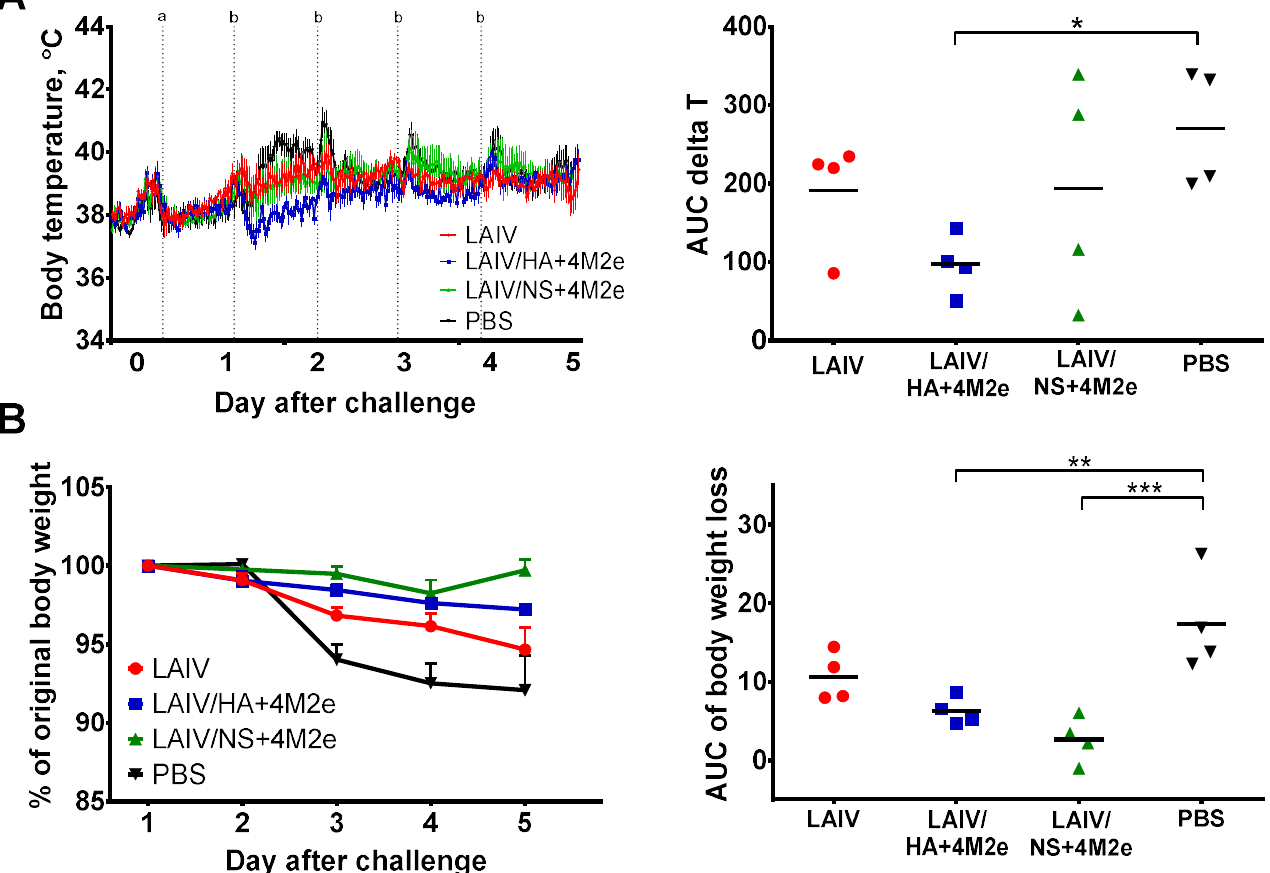
Figure 9. Protection against challenge virus by clinical outcomes. ( A ) Data of body temperature recorded every 30 min were retrieved from the implanted temperature loggers (left graph). The AUC of delta T values were determined for each ferret based on an individual basal temperature, using the trapezoidal rule (right graph). ( B ) Body weigh was recorded daily over the challenge phase and is presented as the mean % of original body weight of each test group with SEM (left graph). The AUC values for the % weight loss were calculated for each animal using the trapezoidal rule (right graph). Data were analyzed by one-way ANOVA with Tukey’s post-hoc multiple analyses test. * p < 0.05; ** p < 0.01, *** p < 0.001.